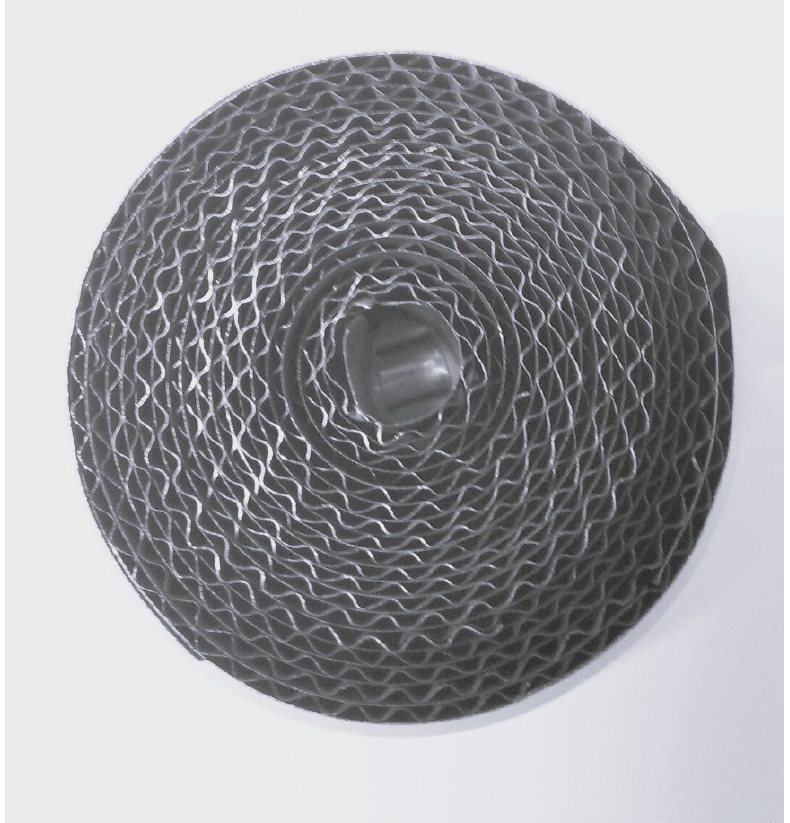
Figure 2. Catalytic Ni 3 Al combustor.